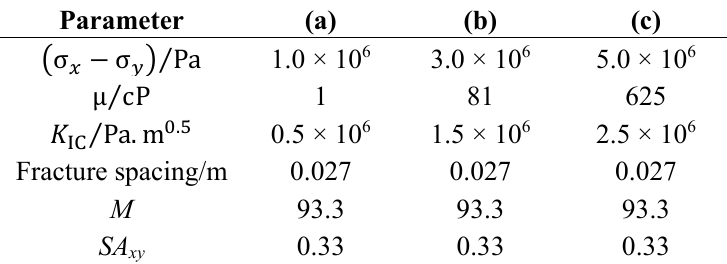
(cid:3398) σ (cid:3404) 3 MPa, (cid:3051) (cid:3052) (cid:3404) 2.5 MPa. m (cid:2868).(cid:2873) . (cid:2893)(cid:2887)